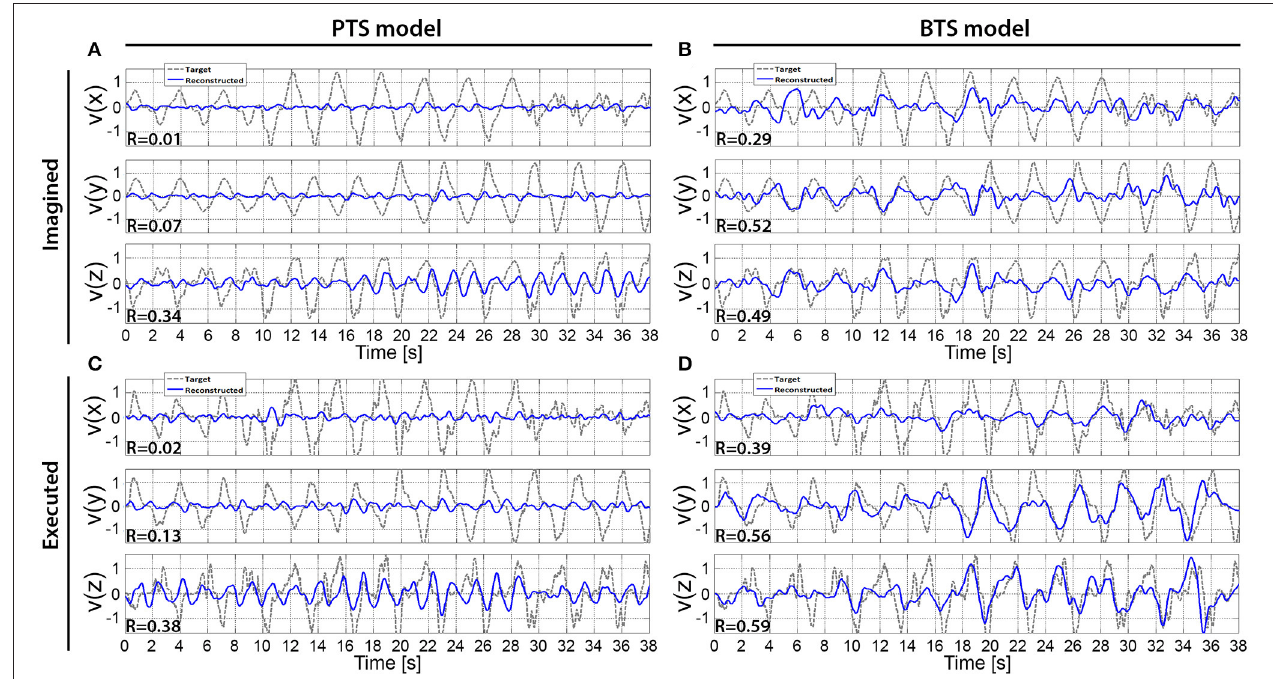
FIGURE 9 | Reconstructed hand velocity vector components of single kinematic trials. V(x), v(y), and v(z) velocity vector components are matched with executed or imagined movement in horizontal, vertical, and depth directions, respectively. For the imagined movement reconstruction (A,B) , the target trajectory was calculated based on executed arm movement trials that were registered using the experimental protocol that was used for the run with imagined arm movements. The imagined arm movement velocity reconstruction is presented in (A,B) for the PTS and BTS models, respectively. The executed arm movement velocity reconstruction is presented in (C,D) for the PTS and BTS models, respectively. (A,B) are calculated based on subject 2, run 4, and outer fold 1 using the time-resolved low delta (0–2Hz) band-pass filtered EEG for (A) and PSD of the low gamma (28–40Hz) band for (B) , while (C), and (D) are calculated based on subject 2, run 2, and outer fold 1 using the time-resolved low delta (0–2Hz) band-pass filtered EEG for (A) and the time-resolved PSD of the low beta (12–18Hz) band for (D)